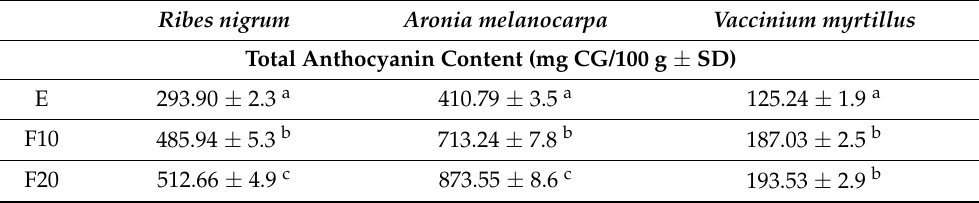
Table 3. Total anthocyanin content in R. nigrum , A. melanocarpa , and V. myrtillus extract and kombucha ferments in mg per 100 g of plant material expressed as an equivalent of cyanidin 3-O-glucoside (CG).